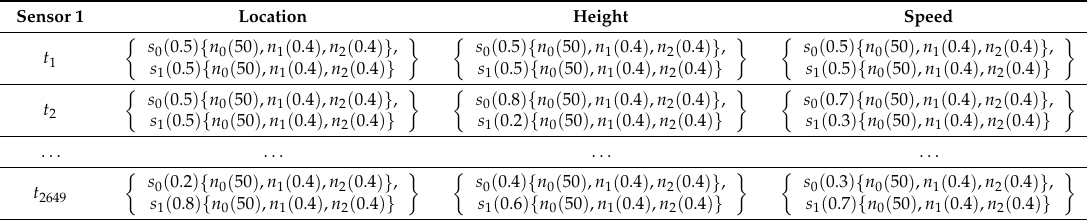
Table 3. Part of the individual evaluation matrix of sensor 1.